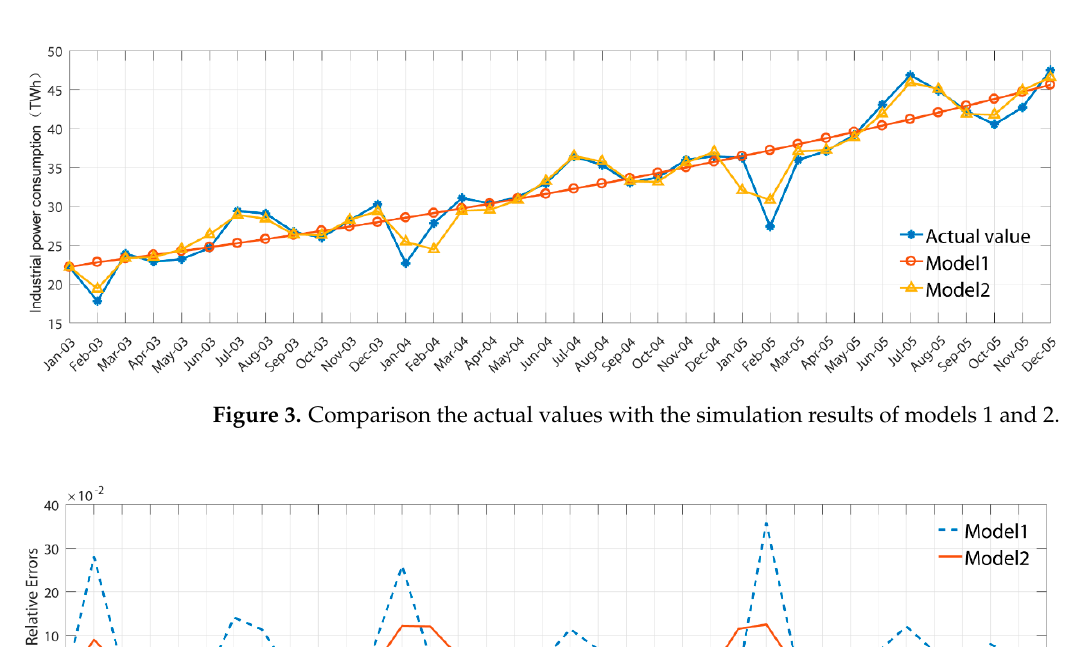
Figure 3. Comparison the actual values with the simulation results of models 1 and 2.